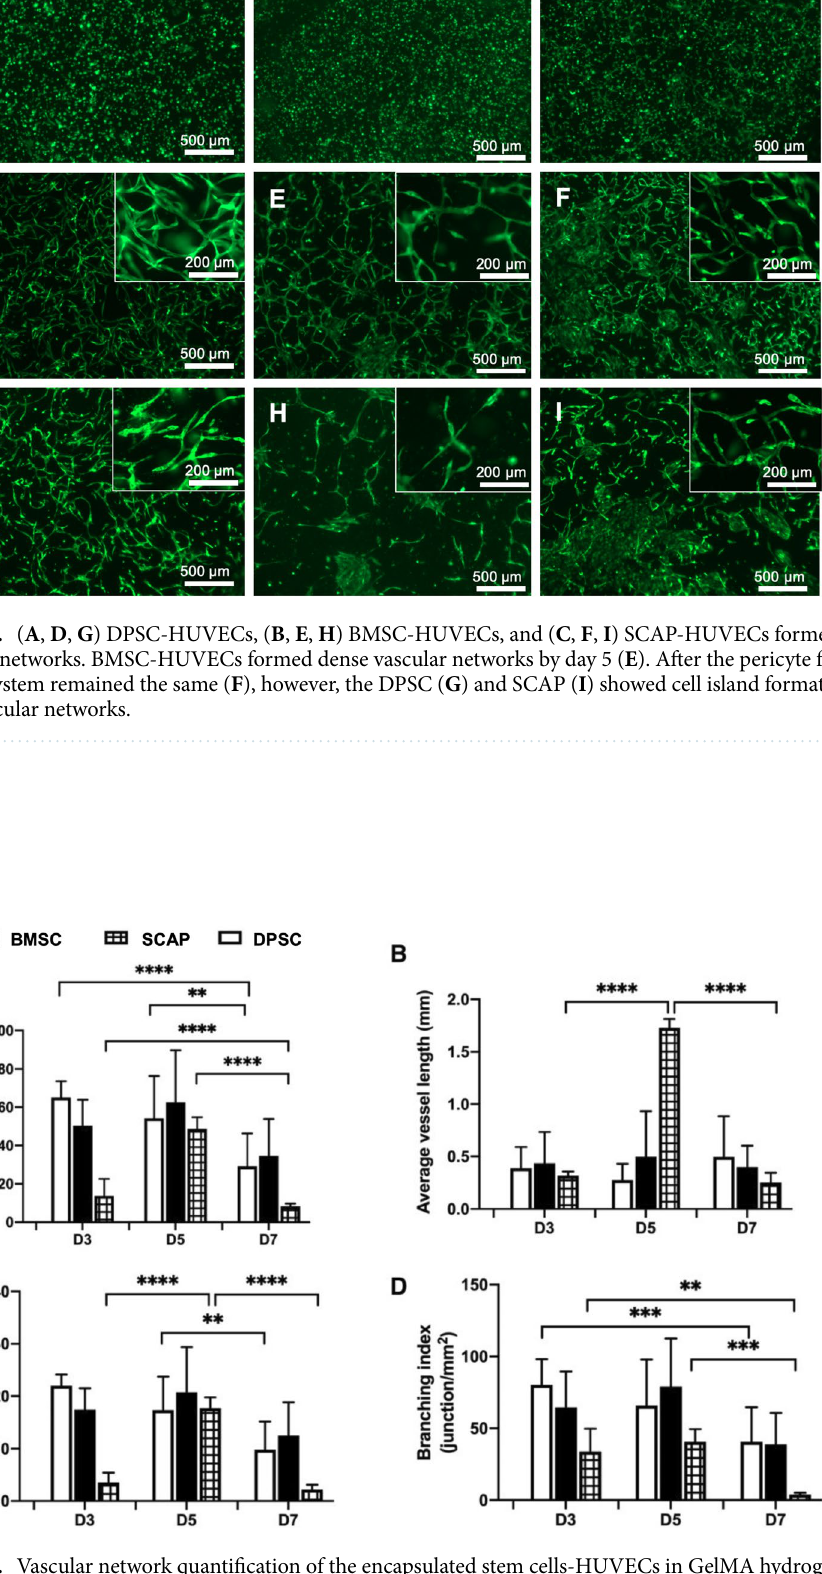
Figure 4. Vascular network quantification of the encapsulated stem cells-HUVECs in GelMA hydrogel. The vascular network parameters, namely, ( A ) total vessel length, ( B ) average vessel length, ( C ) vessel percent area, and ( D ) branching index showed a marked decrease from day 5 to day 7 owing to the effect of